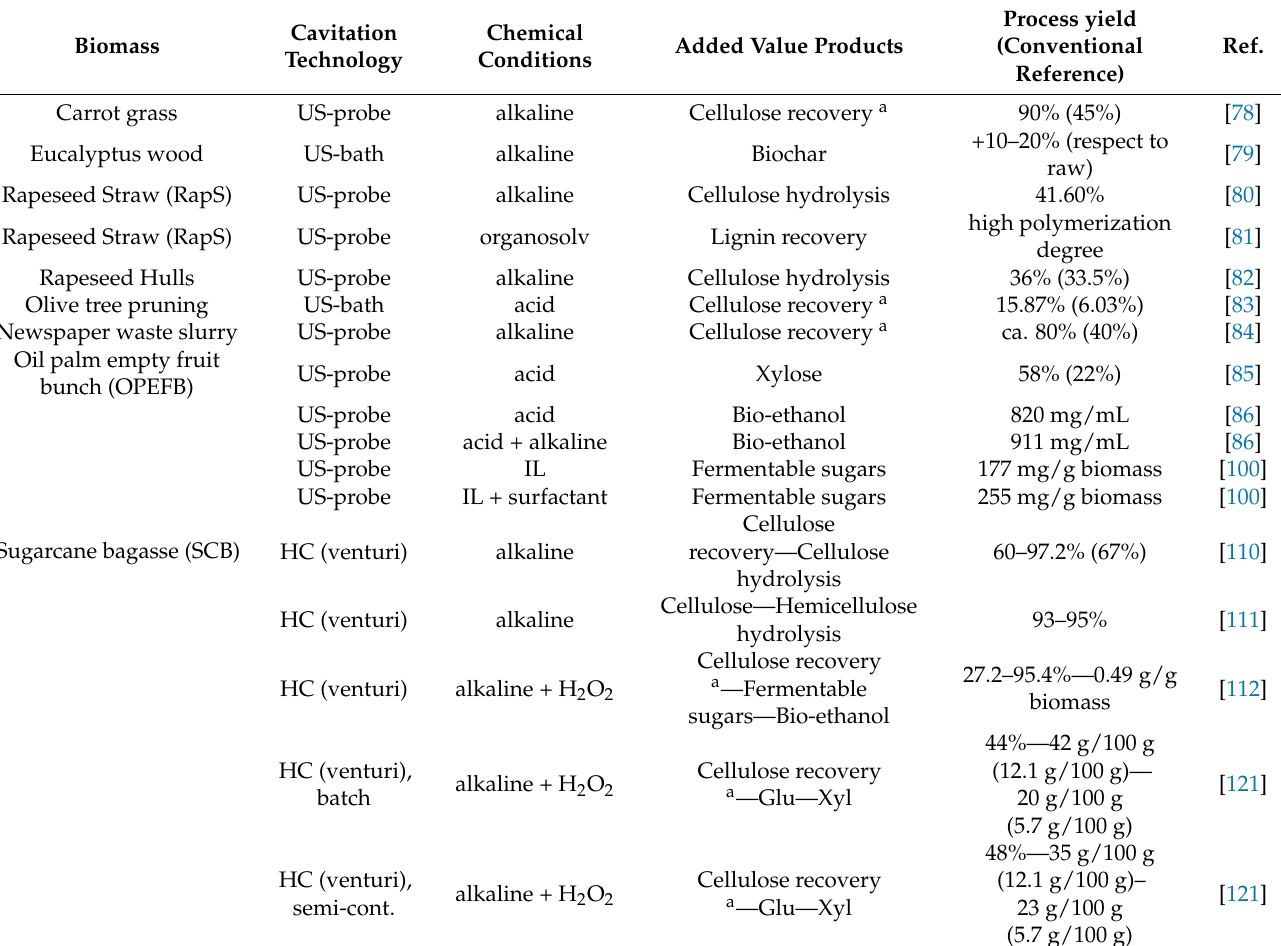
Table 5. Agri-Food Residues valorisation by cavitational